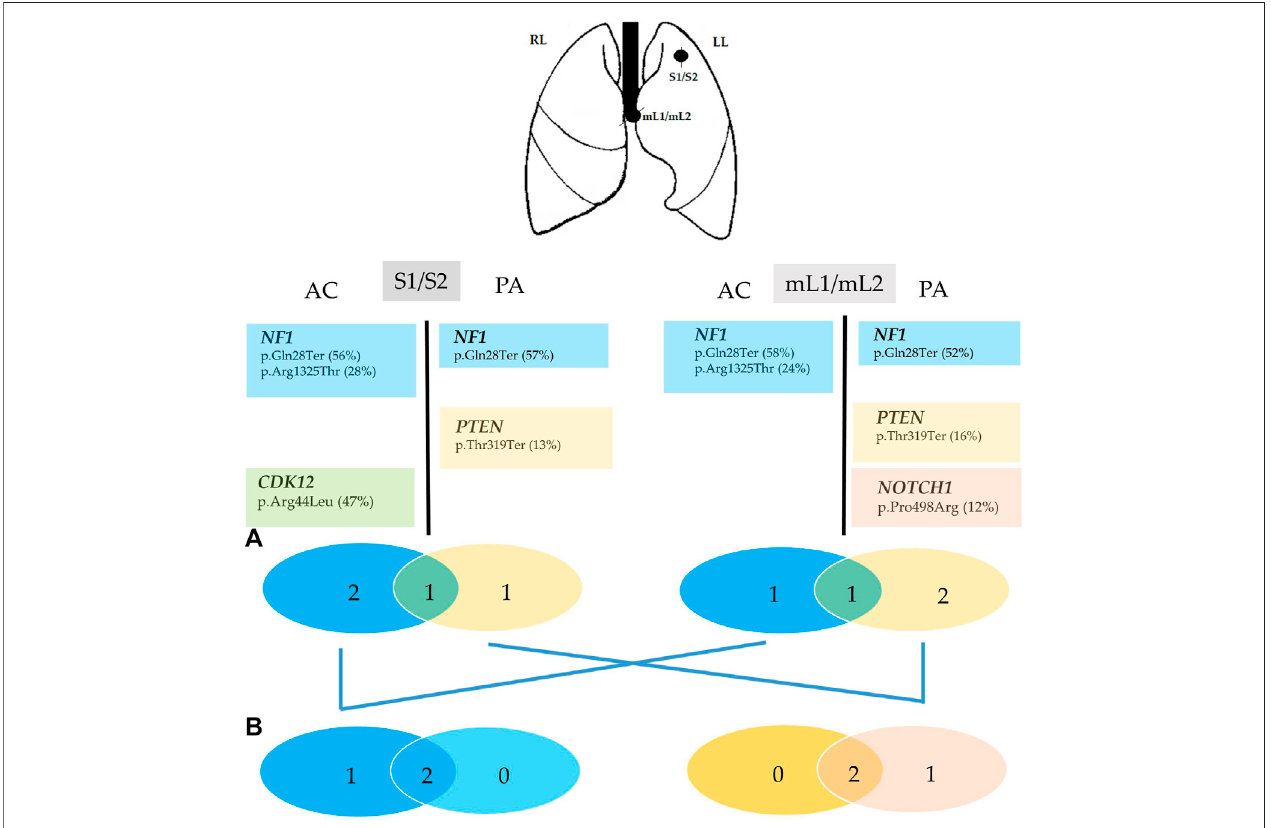
FIGURE 5 | Summary of the genomic fi ndings of Case 2. Genes with mutations identi fi ed in each tumor entity of the superior left lung (S1/S2) and hilar lymphnode metastasis are listed as symbol and aminoacidic changes (% mutant allele fraction). The Venn diagrams (A) were used to show the relationship of somatic mutations between the S1 (blue circle) and S2 (yellow circle), nL1 (blue circle) and mL2 (yellow circle) in the patient. The number represents the somatic mutations identi fi ed in the corresponding samples, and the numbers in the overlapped green regions are the ubiquitous somatic mutations between the two concurrent tumor components (S1/S2, mL1/mL2) in the same patient. The Venn diagrams (B) were used to show the relationship of somatic mutations between the carcinoid component of S1 and between the adenocarcinoma component of S2 and mL2. The numbers represent the somatic mutations identi fi ed in the corresponding samples, and the numbers in the overlapped regions are ubiquitous somatic mutations shared by the components with the same histology in primary and metastatic sites.S1/S2, mixed carcinoid/ adenocarcinomatumor ofthesuperiorlung;mL1/mL2,mixedcarcinoid/adenocarcinomahilarlymphnodemetatsasis.LL,leftlung; RL,rightlung. AC,atypicalcarcinoid; PA, pulmonary